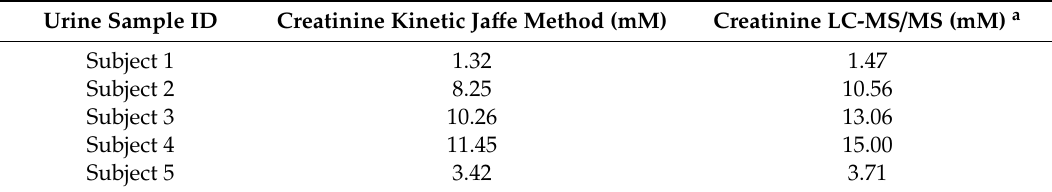
Table 5. Creatinine concentration in urine of healthy human subjects ( n = 5).